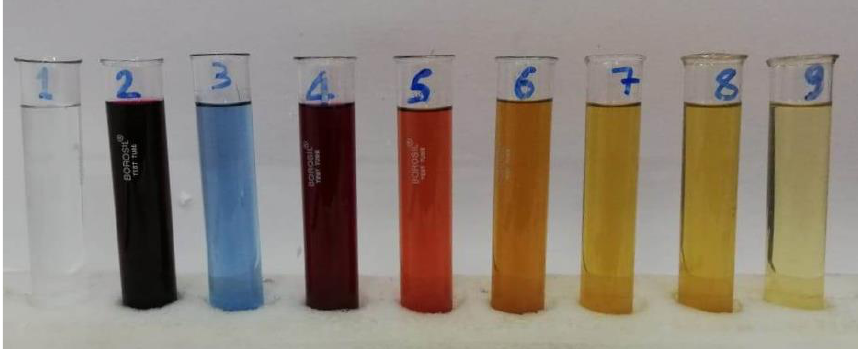
Figure 12. Colour of the solutions before and after bioremediation: 1. distilled water; 2. AR119 in